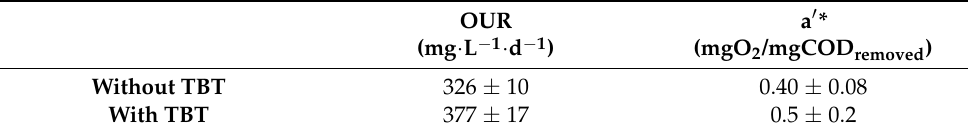
Table 3. Values for average OUR and oxygen consumption rate measured during the experiments.